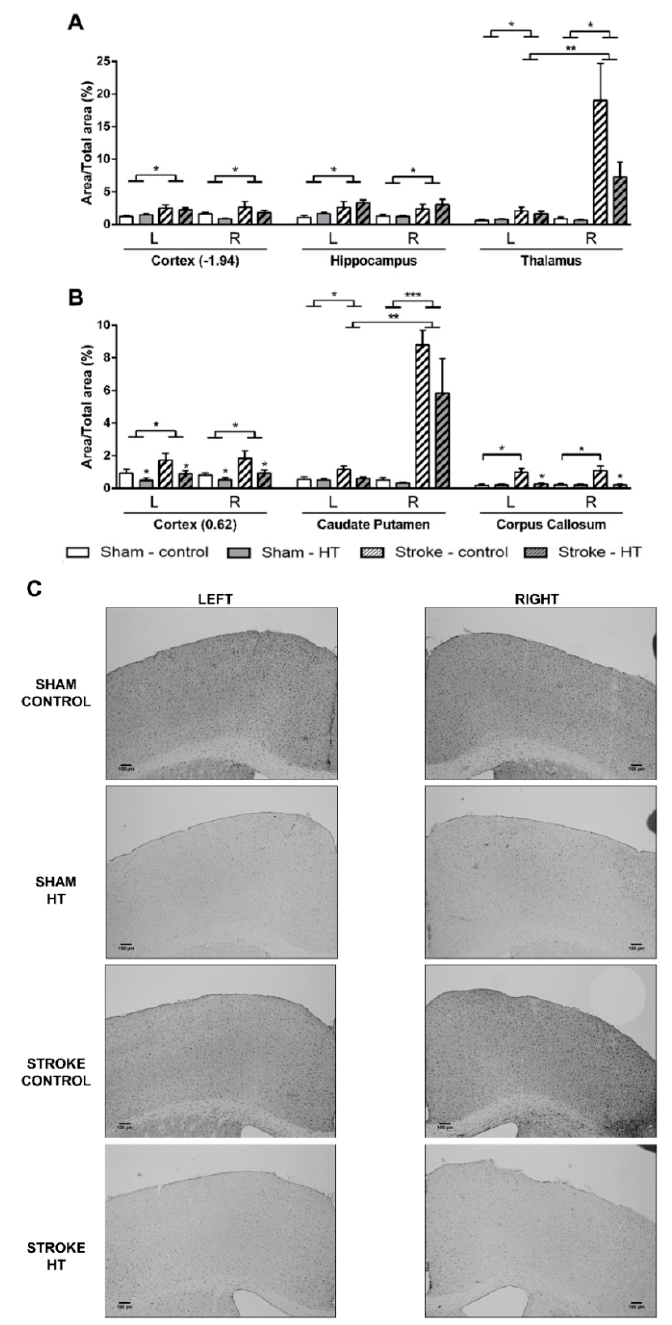
Figure 14. Immunohistochemical stainings for ionized calcium-binding adapter molecule-1 (IBA-1) in brains of HT and control-fed mice 35 days after surgery. All stroke mice showed a higher IBA1 + -area than sham mice in ( A ) the cortex (bregma − 1.94) ( p < 0.046), hippocampus ( p < 0.019), in both left ( p < 0.002) and right ( p < 0.002) thalamus, ( B ) cortex (bregma 0.62) ( p < 0.027), and in both left ( p < 0.037) and right ( p < 0.001) caudate putamen. ( B ) Notably, in the corpus callosum, only in stroke-control mice a heightened IBA1 + -area was found compared to sham-control mice ( p < 0.011). Moreover, only in stroke mice in the right thalamus ( p < 0.006) and in the right caudate putamen ( p < 0.001) IBA1 + -area was increased compared to their corresponding left hemispheric part. In the cortex at bregma 0.62, HT diet lowered IBA1 + -area compared to control diet in both sham and stroke mice ( p < 0.039). In the corpus callosum, IBA1 + -area was decreased by HT diet only in stroke mice ( p < 0.022). ( C ) Representative images of IBA-1 staining in cortex (bregma 0.62). Values represent mean ± SEM. * p < 0.05, ** p < 0.01, *** p < 0.001.